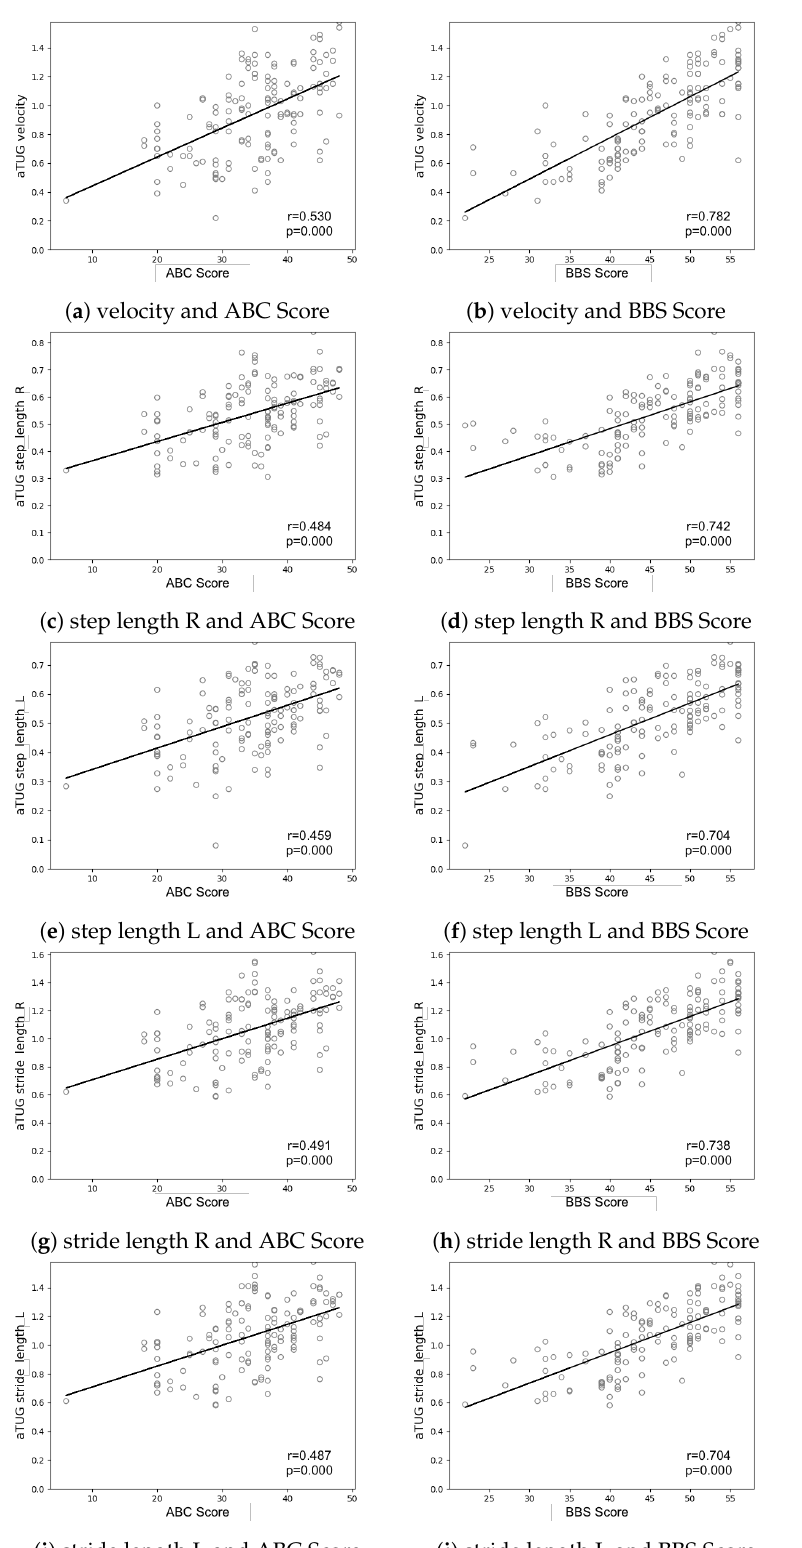
Figure 5. Scatterplot distribution among aTUG measured gait parameters, with ABC and BBS scores (partially leg-specific where applicable L = left, R = right